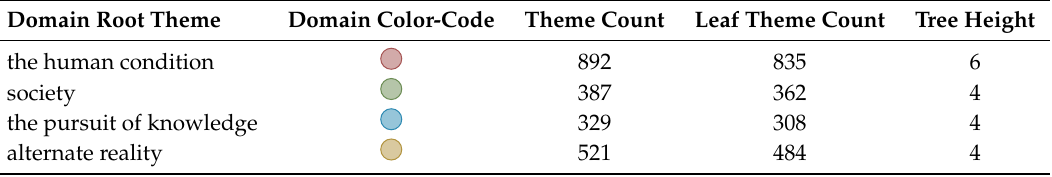
Figure 2. Literary Theme Ontology v0.1.3 class hierarchy overview. ( A – D ) show “the human condition”, “alternate reality”, “society”, and “the pursuit of knowledge” domain themes to three levels of depth, respectively. Table 2. Literary Theme Ontology v0.1.3 summary